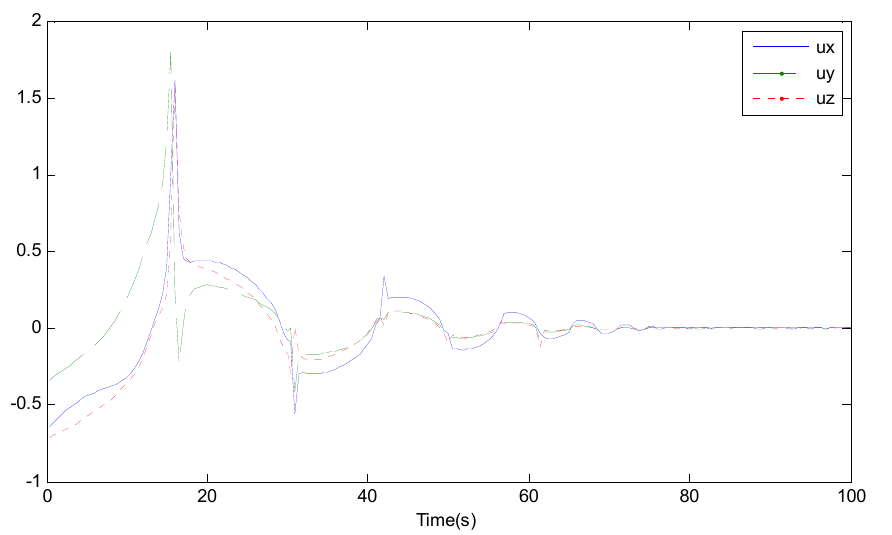
Figure 19. Curve of sliding mode parameter.